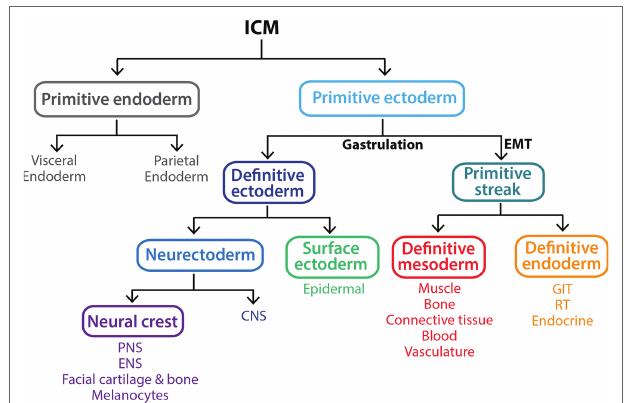
FIGURE 3 | Gastrulation gives rise to the three primary germ layers of the embryo proper. The inner cell mass (ICM) is a pluripotent population of cells that arises between 3.5 and 4.5 dpc within the blastocyst. By 5.5 dpc, the ICM differentiates into the multipotent extraembryonic primitive endoderm lineage and a second pluripotent population, the primitive ectoderm. At 6.5 dpc, the primitive ectoderm undergoes gastrulation in response to various signals including Nodal, resulting in a subset of cells undergoing an epithelial- to-mesenchymal transition (EMT), allowing them to ingress through the primitive streak and form the definitive mesoderm and definitive endoderm germ layers. The remaining primitive ectoderm cells (which see little or no Nodal) do not move through the streak and give rise to the definitive ectoderm germ layer, which further differentiates into the surface ectoderm and neurectoderm in response to the presence and absence of BMP4 signaling, respectively. Key: CNS, central nervous system; ENS,